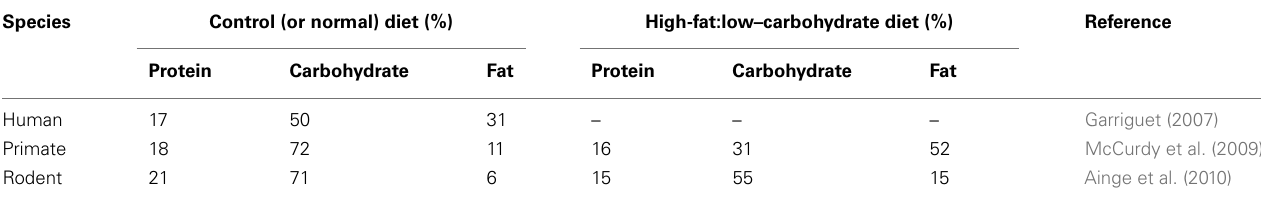
Table 1 | Comparison of the macronutrient composition of a standard adult human diet with those used in nutritional studies involving primates and rodents.